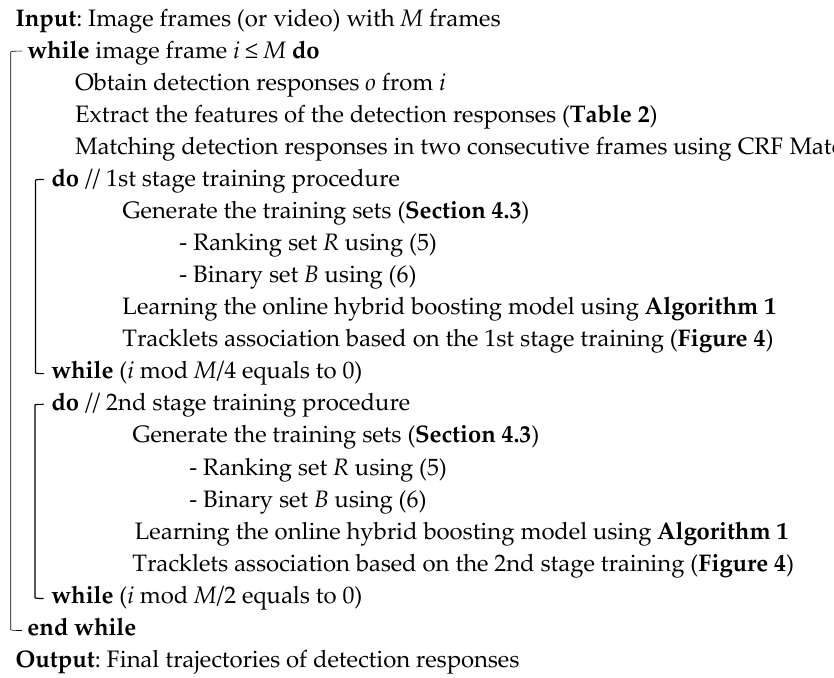
Algorithm 2: CRF-Boosting Tracker with the Two-Stage Training Procedure Input : Image frames (or video) with M